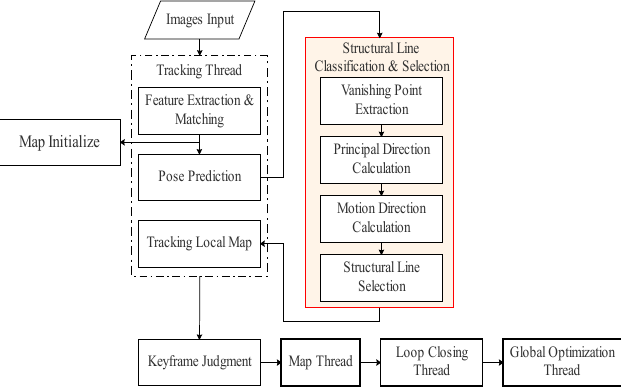
Figure 4. Flowchart of the method in this